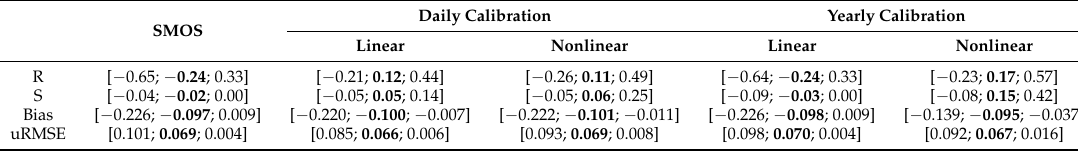
Table 2. Range of correlation coefficient, slope of the linear regression, bias (m 3 /m 3 ), uRMSE (m 3 /m 3 ) between SMOS SM/DISPATCH SM and in situ data. DISPATCH is tested with both linear and nonlinear modes, and with both daily and yearly calibrations. Note that for each range interval, the mean value (simple average for all days) of correlation, slope, bias and uRMSE is also mentioned in bold. Daily Calibration Yearly Calibration SMOS Linear Nonlinear Linear Nonlinear